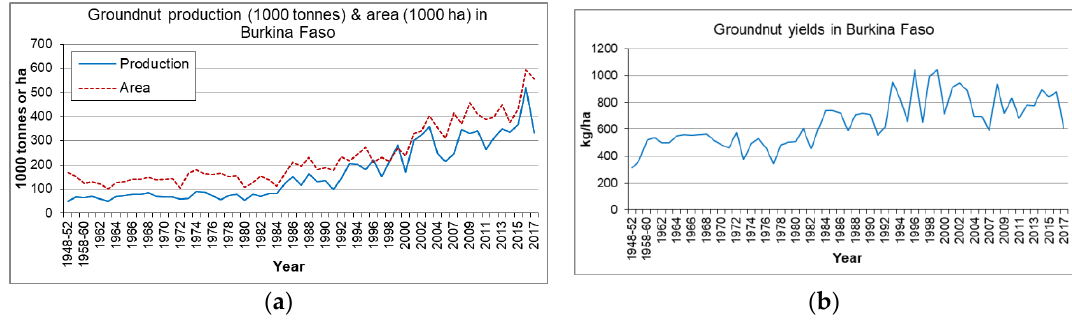
Figure 1. Evolution of groundnut ( a ) production (1000 tonnes; shelled) and area (1000 ha); ( b ) yield (kg/ha) in Burkina Faso between 1948 and 2017 [4,22,23].